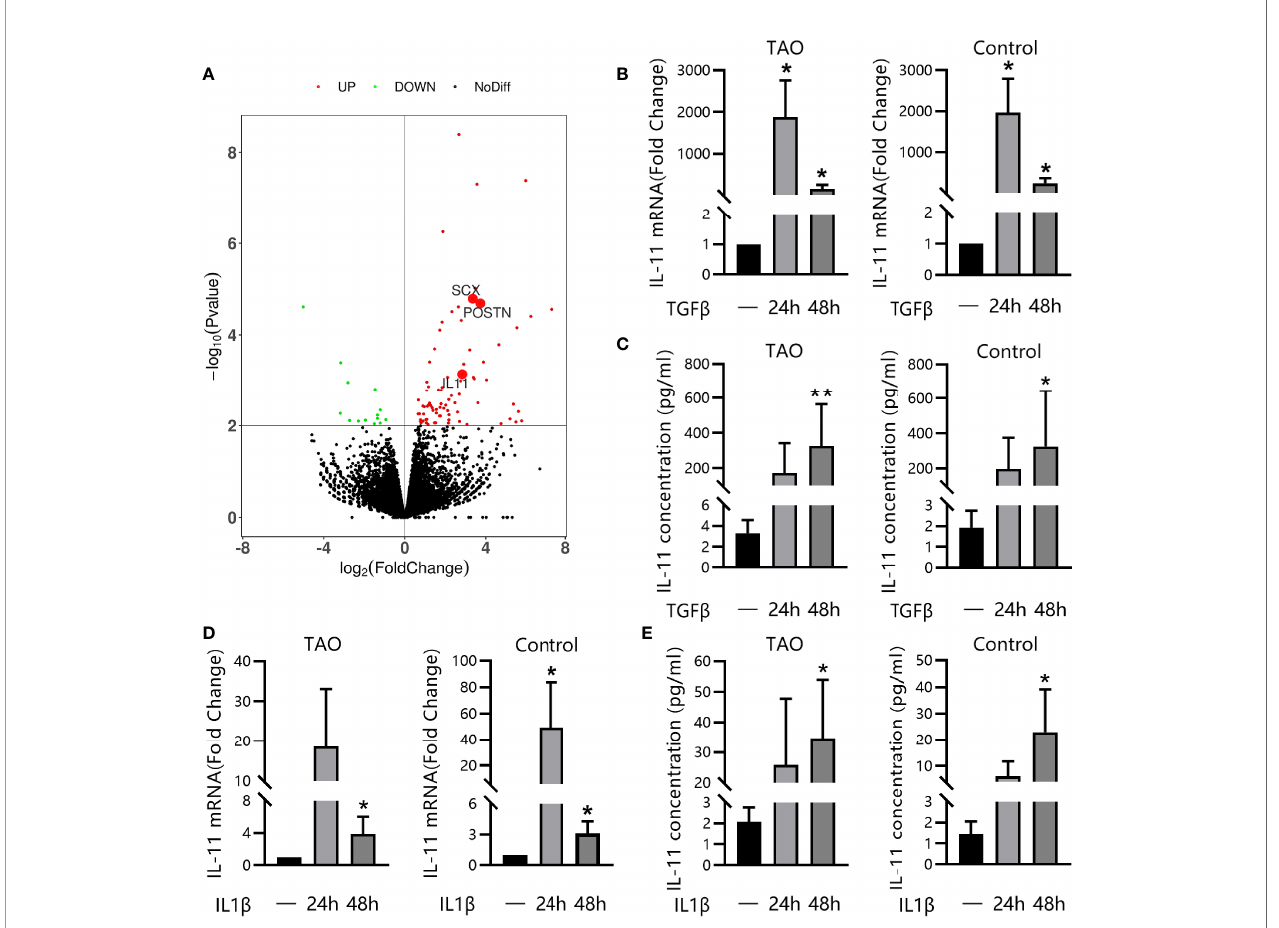
FIGURE 4 | IL-11 was Secreted by OFs in Response to TGF- b 1 or IL-1 b . (A) RNA sequencing of thyroid-associated ophthalmopathy (TAO) orbital fi broblasts (OFs, n = 3) with or without TGF- b 1 treatment (10 ng/mL, 48 h). DEseq2 10 -fold change in expression and P values are shown. (B, C) Quantitative real-time polymerase chain reaction (qRT-PCR, TAO, n = 5; control, n = 5) and enzyme-linked immunosorbent assay (ELISA, TAO, n = 8; control, n = 8) of IL-11 expression in orbital fi broblasts (OFs) after stimulation with TGF- b 1(10 ng/mL, 48 h). (D, E) QRT-PCR (TAO, n = 6; control, n = 6) and ELISA (TAO, n = 5; control, n = 5) of IL-11 expression in orbital fi broblasts (OFs) after stimulation with IL-1 b (5 ng/ml, 48 h). The data are expressed as the mean ± standard deviation (SD). *P < 0.05, **P < 0.01 as compared with the control; ns denotes no statistical signi fi cance versus the control; assessed by Tukey ’ s corrected one-way analysis of